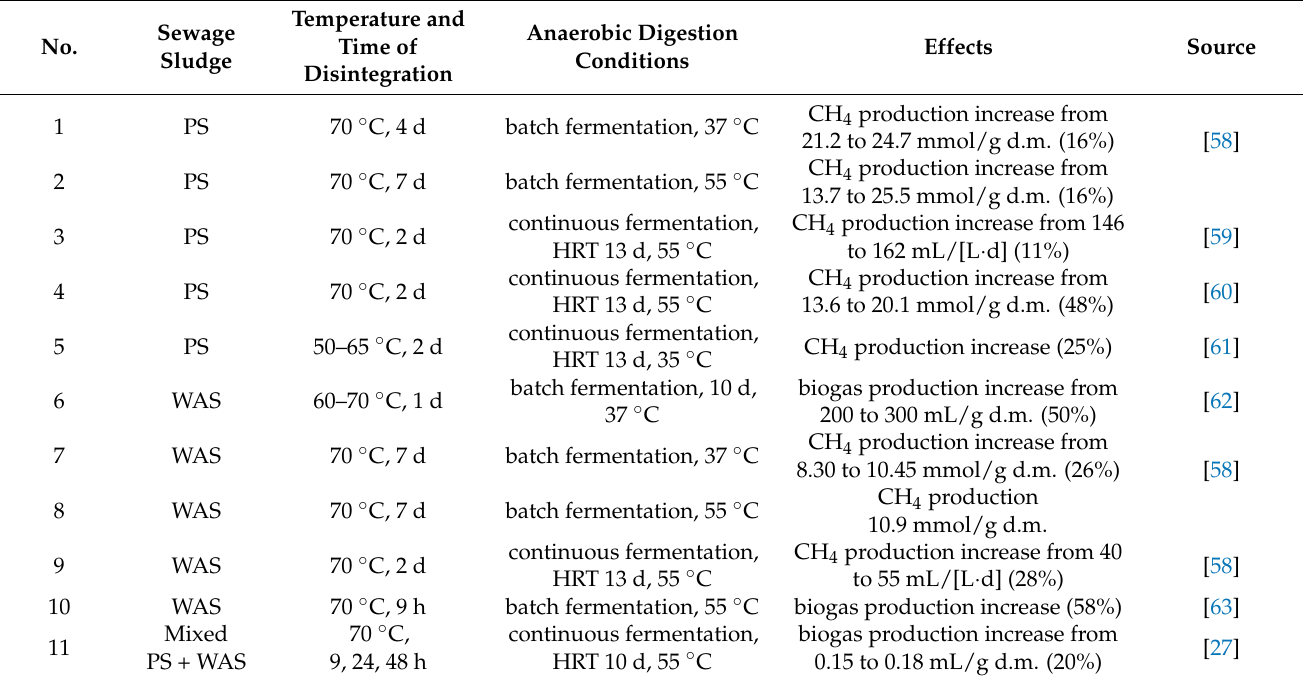
Table 1. Impact of low-temperature disintegration of sewage sludge on fermentation